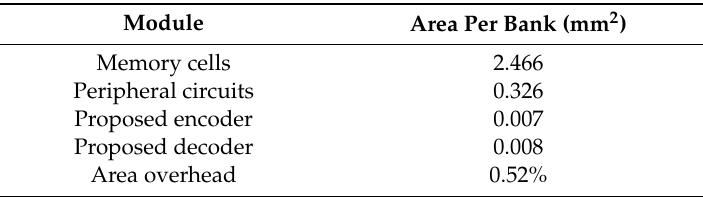
Table 8. Area overhead of proposed